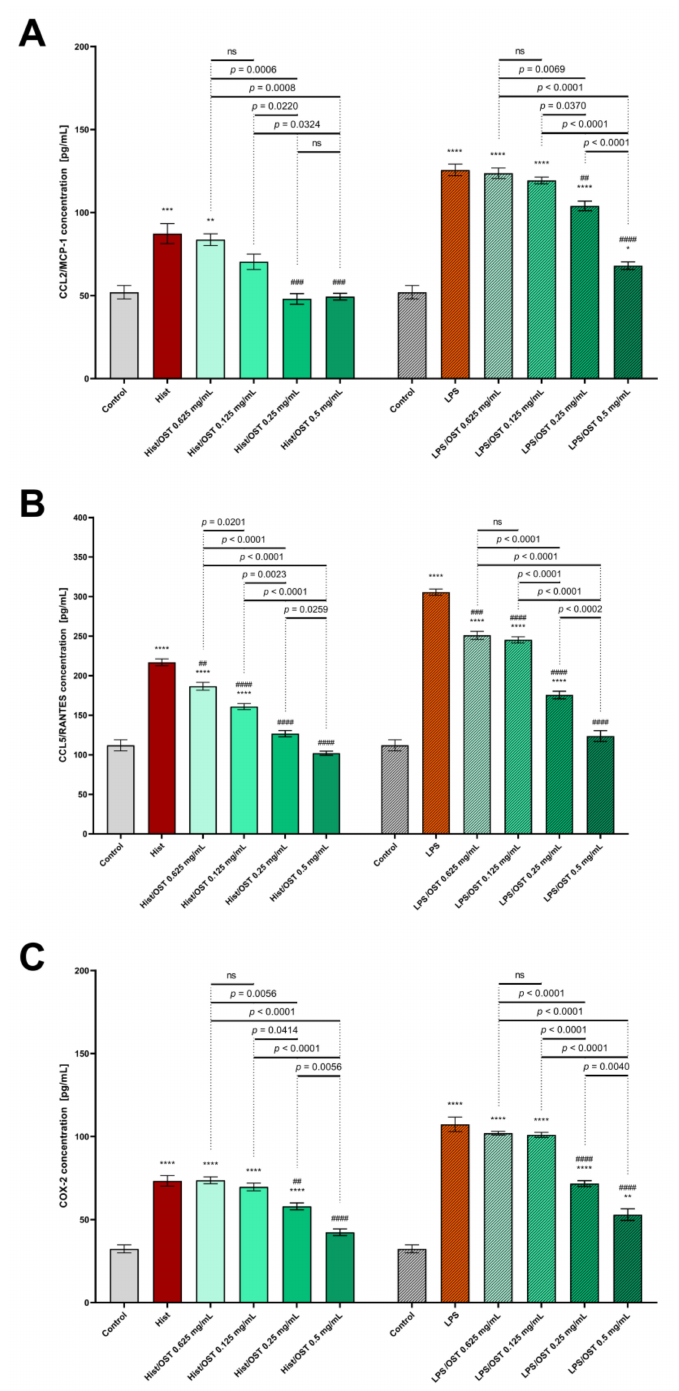
Figure 6. Secretion of CCL2/MCP-1 ( A ); CCL5/RANTES ( B ) and COX-2 ( C ) in the 3D skin model after incubation with histamine (Hist; 100 µ g/mL), lipopolysaccharides (LPS; 2 µ g/mL) alone and in mixtures with osthole (OST; 0.0625–0.5 mg/mL). The horizontal line shows the mean and the bars show the standard error of the mean. Statistically significant differences (one-way ANOVA with Tukey’s multiple comparisons test) compared to control (*— p < 0.05 , **— p < 0.01, ***— p < 0.001, ****— p < 0.0001) and to cells treated with histamine or LPS (##— p < 0.01, ###— p < 0.001, ####— p < 0.0001) are marked;